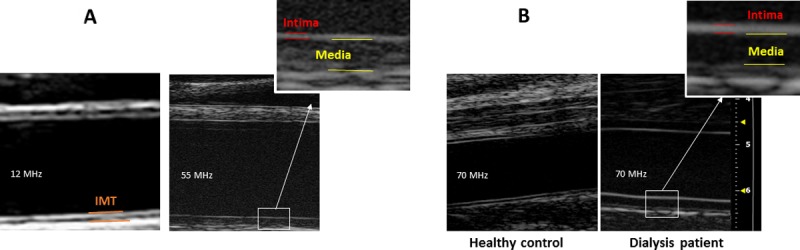
Ultra-high-frequency ultrasound images of carotid and dorsal pedal arteries, and comparison with images obtained by conventional ultrasound.Fig 1A—Carotid artery scanned with 12 MHz (left) and 55 MHz (right) ultrasound. Outtake shows magnification of intima-media complex from 55 MHz image with outline of intima and media thickness. Fig 1B—Dorsal pedal artery of control child (left) and child on hemodialysis (right) scanned with 70 MHz probe).